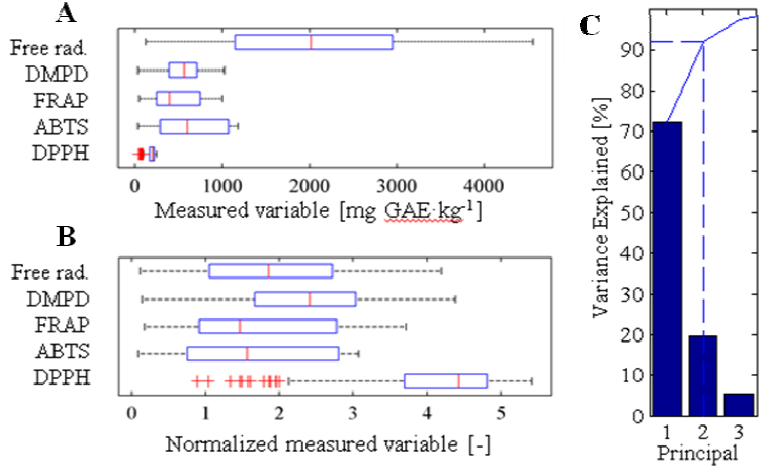
Figure 7. Statistical evaluation of antioxidant activities measured by Free radicals, DMPD, FRAP, ABTS and DPPH. Box plot graphs demonstrating rate of dispersions of individual methods for: ( A ) original measured data; ( B ) and for normalised values according to standard deviation; ( C ) representation of obtained principal